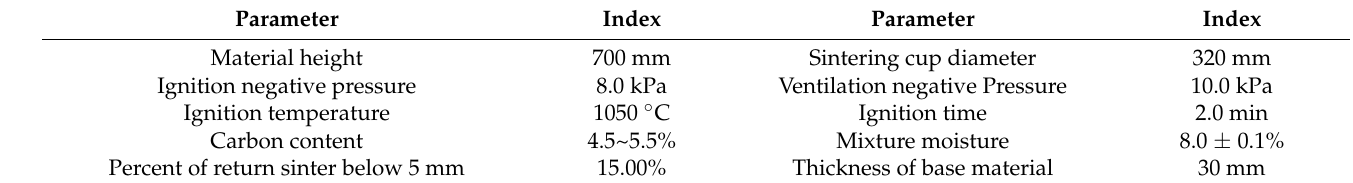
Table 1. Chemical composition of sintering materials/wt%.